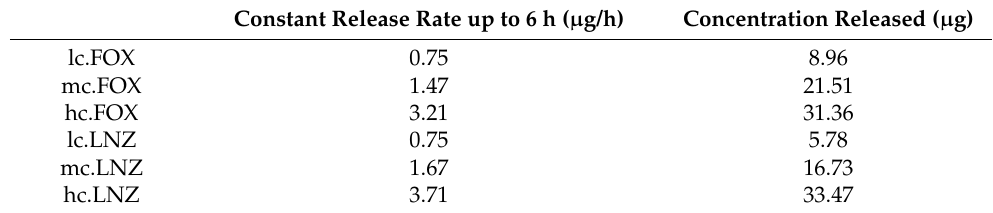
Table 1. Constant release rate up to 6 h and maximum concentration released reached for